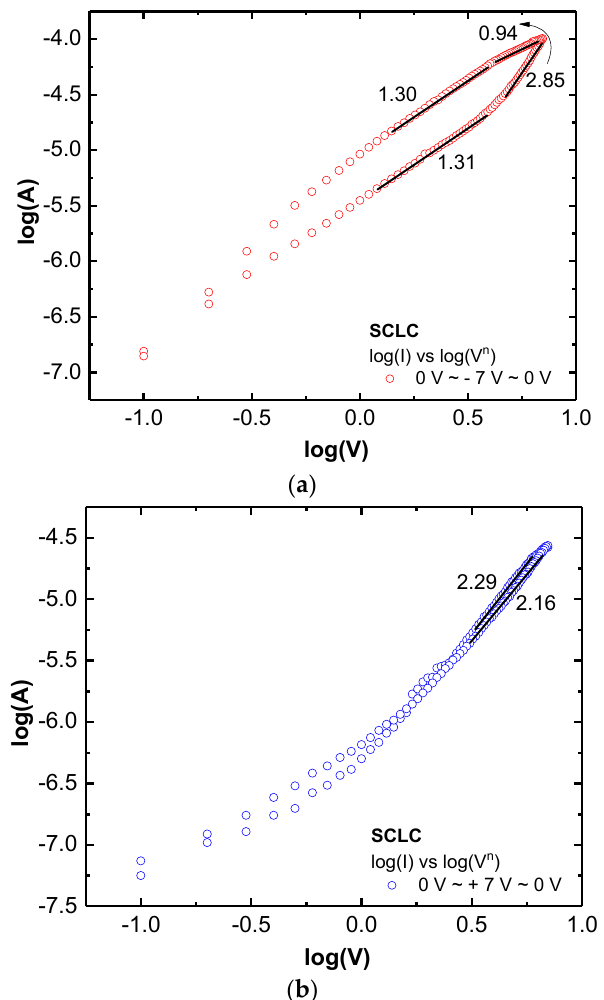
Figure 4. ( a ) Logarithmic plot for eight-wise voltage sweep (0 V → − 7 V → 0 V → 7 V → 0 V) ( a ) plot of 0 V → − 7 V → 0 V. ( b ) logarithmic plot for eight-wise voltage sweep (0 V → − 7 V → 0 V → 7 V → 0. V →